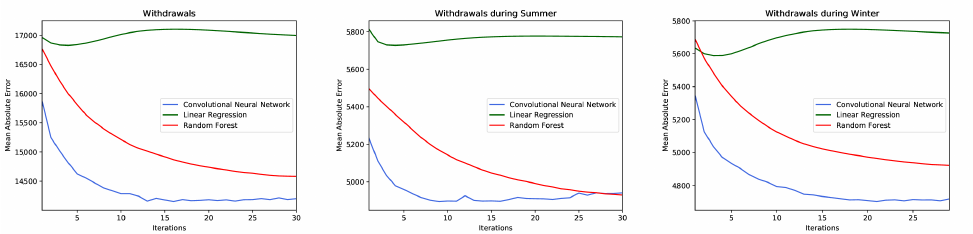
Figure 9. Error values when using different regression algorithms in the proposed self-training approach for the overall amount of national withdrawals, the amount of national withdrawals during the summer, and the amount of national withdrawals during the